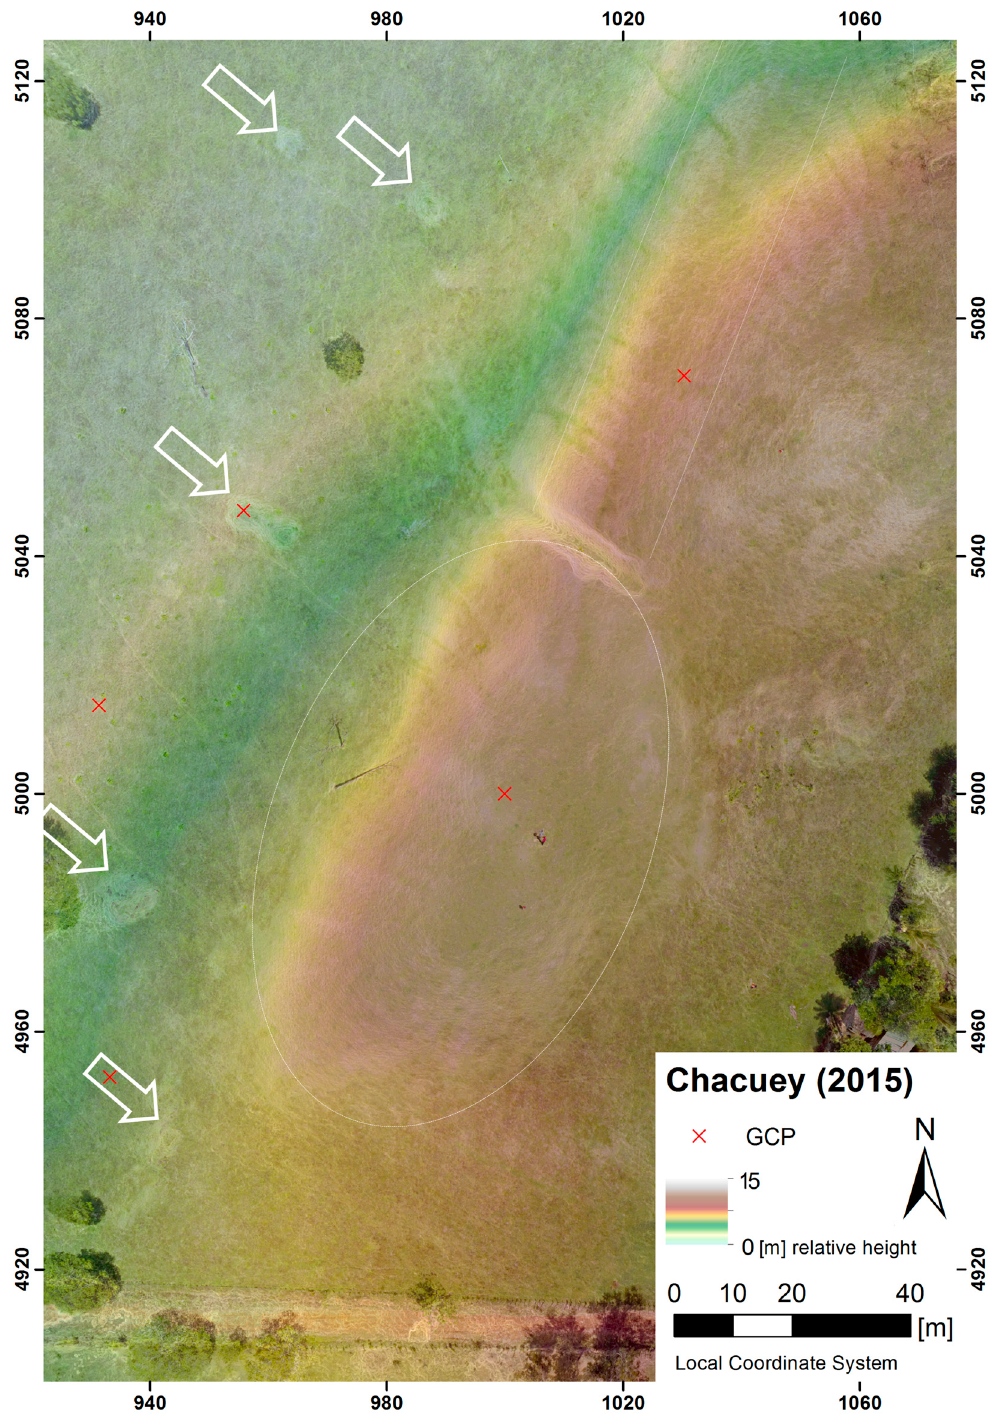
Figure 9. Orthophoto and DEM overlaying GIS slope calculations of the oval shaped mound of the ball court site of Chacuey. White arrows mark rock piles possibly associated with the former function of the